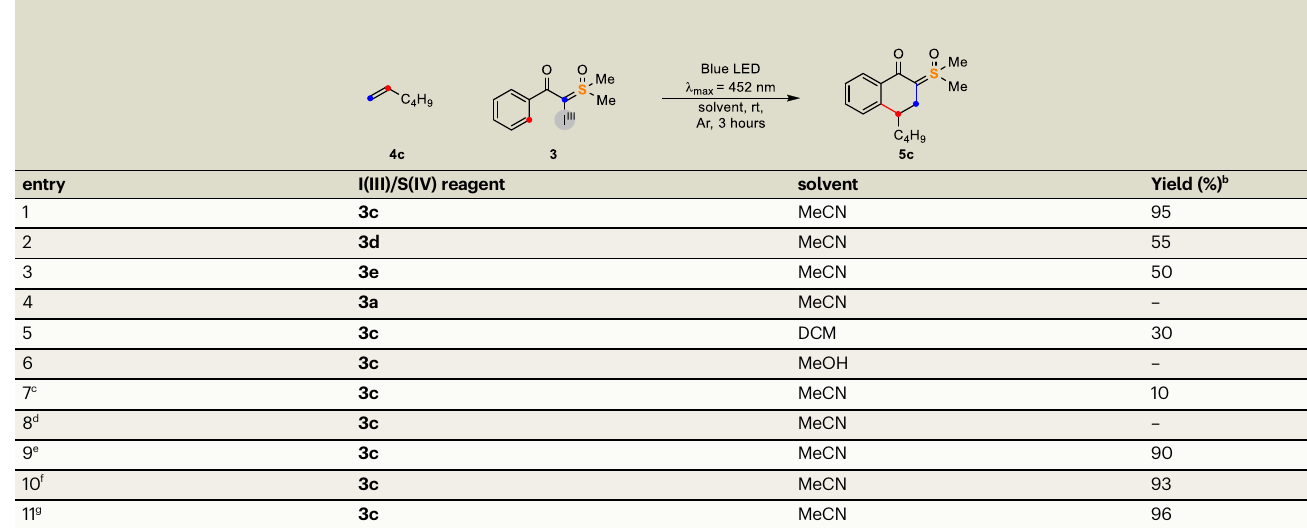
Table 1 | Optimization studies of [4 + 2] cycloaddition reaction with ole fi ne a